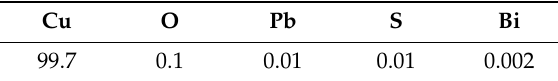
Table 1. Chemical Composition of Copper (in wt.%).